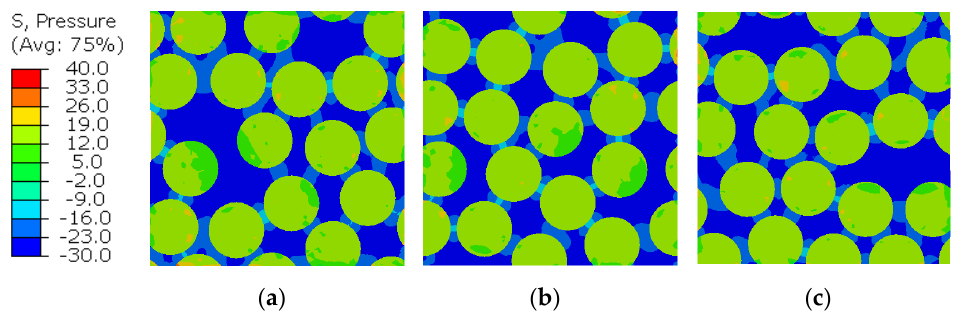
Figure 8. RVE micro-residual hydrostatic stress distribution for ( a ) RVE1, ( b ) RVE2 and ( c ) RVE3. To investigate the stress components evolution during the curing process, Figure 9 shows the von Mises stress and the hydrostatic stress components evolution as a function of time, and Figure 10 shows the effective RVE strain measured at the master nodes.